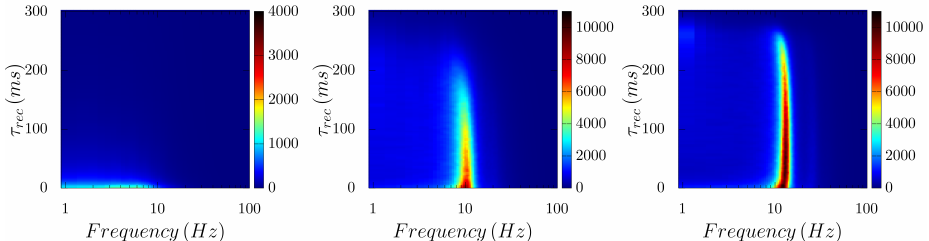
Figure 5. Emergence of “ α rhythms” (around 10 Hz) in the model for noise levels µ = 0.6, 0.8 and 1.0, respectively, from left to right. Although the power of the main frequency peak of the waves decays as STD increases, the case of µ = 1.0 clearly illustrates how these waves details are not dramatically affected by synaptic depression for this noise level and the α band regime remains until τ rec ≈ 260 ms, where the waves disappear (note that this transition becomes explosive for µ (cid:38) 1 as shown in Figure 6).